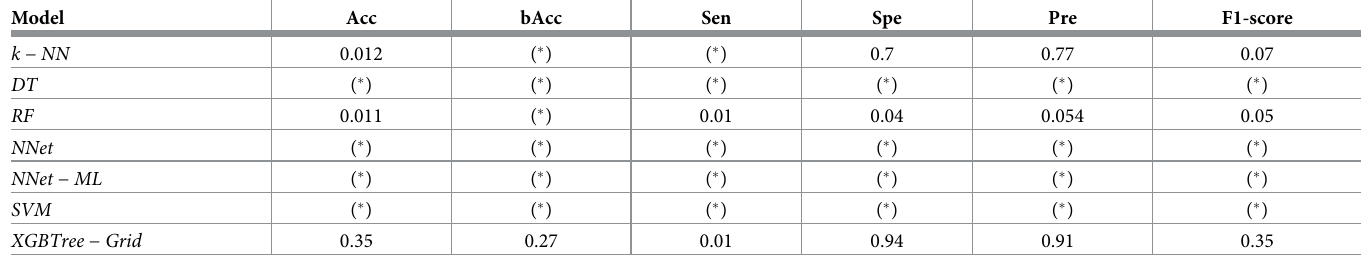
Table 4. p -value of the independent t -test comparing the performance of XGBTree with other models using a 95% confidence interval (Note: ( � ) implies the p -value is much smaller than 0.001).